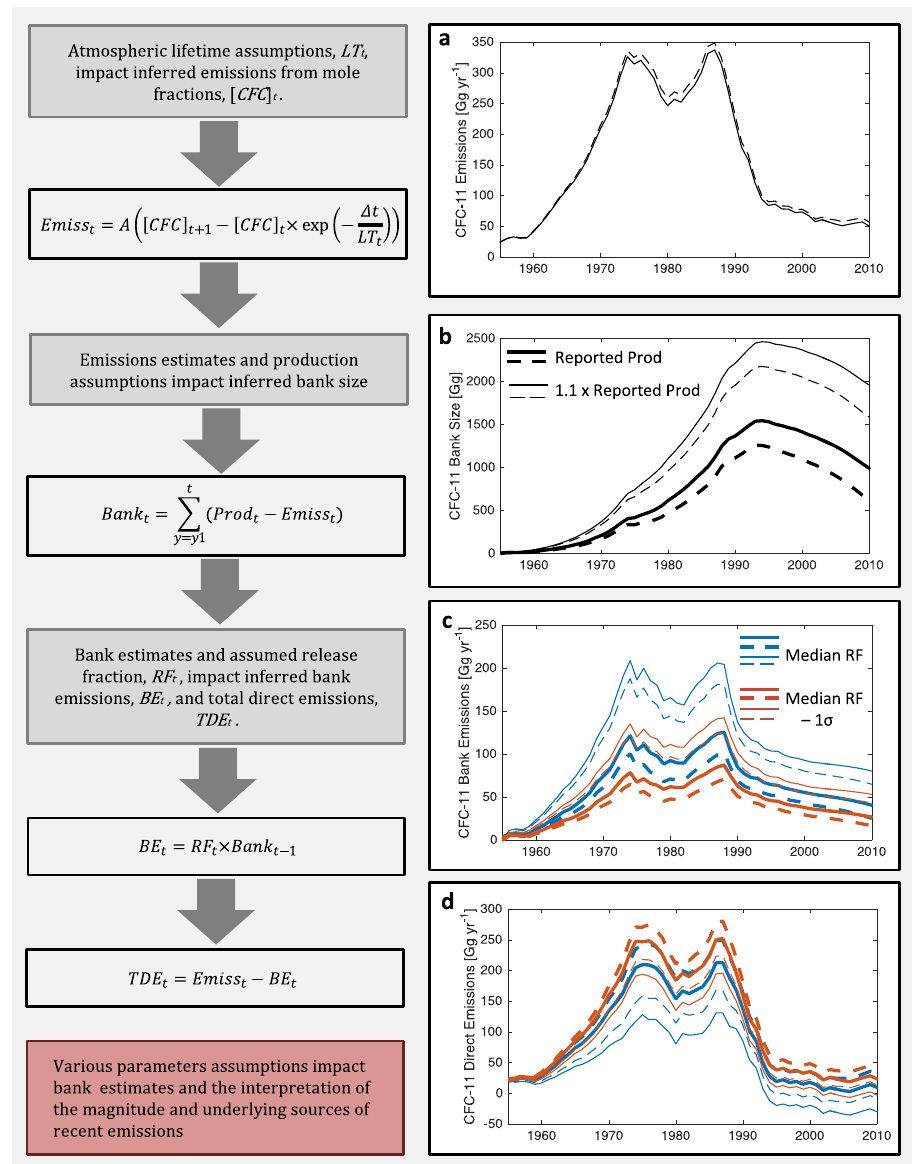
Fig. 1 Impact of parameter assumptions on banks and emissions estimates. Panel ( a ) illustrates the impacts of two atmospheric lifetime (LT) assumptions on inferred total emissions (Emiss) from observed concentrations, while Panels ( b – d ) provide illustrative examples to show the sensitivities of the breakdown of sources of those emissions to components from banks (BE) versus direct emissions (TDE). The solid lines throughout correspond to quantities derived assuming the SPARC multi-model mean time-varying lifetime (with a time-averaged lifetime of 62 years), and the dashed lines correspond to an assumed constant lifetime of 52 years, adopted as the steady state lifetime in the work of Rigby and colleagues 5 and WMO (2018) 3 . Panel ( a ) shows the emissions estimate using the fi rst equation. The parameter, A , is a constant that converts units of atmospheric concentrations to units of emissions. Panel ( b ) shows the bank estimates for the two lifetime scenarios and two illustrative production scenarios; bank estimates using reported production are shown using the thicker lines, and the thinner lines correspond to a production scenario that is 10% larger than reported. Panel ( c ) shows inferred bank emissions for the lifetime scenarios and production scenarios described above. The colors of the lines indicate different bank release fraction (RF) estimates. Blue lines correspond to bank emissions for the median of the prior release fractions distributions used in the analysis from this paper. The red lines correspond to the median − 1 σ of the prior release fraction distribution. Panel ( d ) shows the broad range of resulting inferred direct emissions, with the lines corresponding to the same scenarios used in Panel ( c